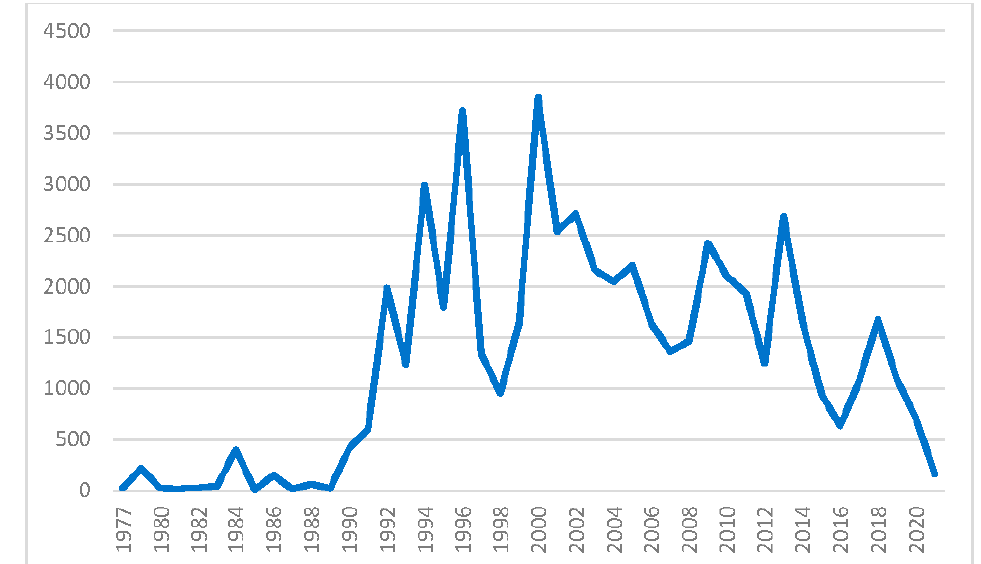
Figure 3. Intertemporal evolution of citations per article and per year.